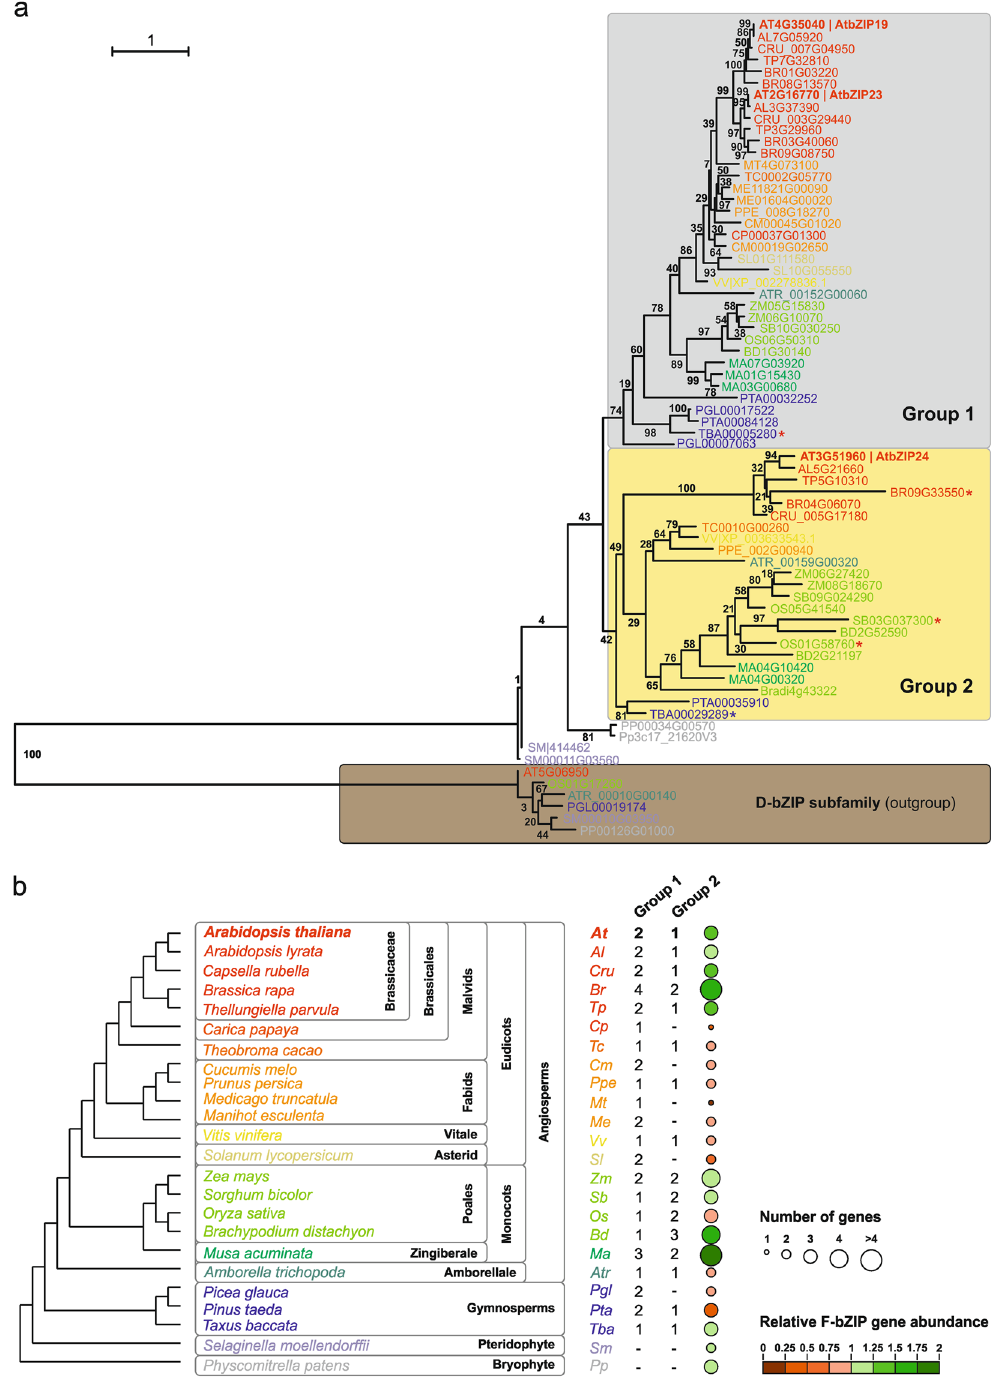
Figure 1. Phylogenetic analysis of the F-bZIP subfamily of proteins in plant species. (a) Proteins of the F-bZIP subfamily from a selection of 24 species representing all major plant taxa were used in the phylogenetic analysis. The phylogenetic tree was constructed using maximum-likehood and bootstrap values from 1000 replicates. Numbers on each branch represent the percentages of bootstrap. Proteins of the D-bZIP subfamily from representative species of different phylogenetic groups were used as an outgroup. Asterisks indicate proteins with missing or incomplete His/Cys-rich motif (red) or bZIP domain (blue). ( b ) F-bZIP gene enrichment for each plant species. Bubble size represents the absolute number of genes present in each species’ genome. Bubble colours indicate the relative size of the F-bZIP subfamily. The relative value was calculated as the ratio of F-bZIPs per total of genes in the genome versus the average of F-bZIPs in all species